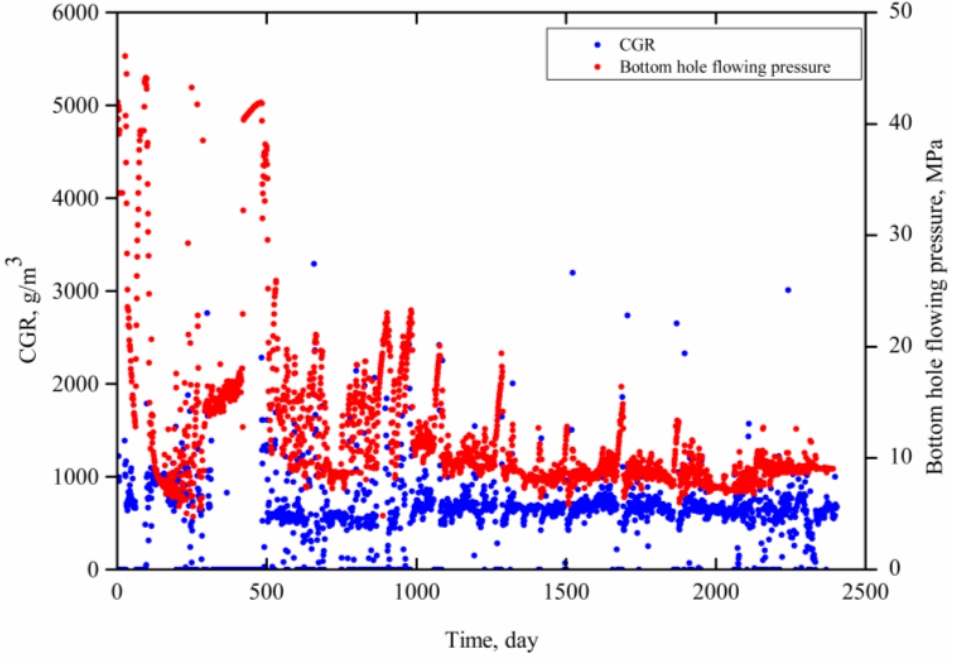
Figure 6. Bottom hole flowing pressure and CGR of the multi-stage fractured horizontal well.